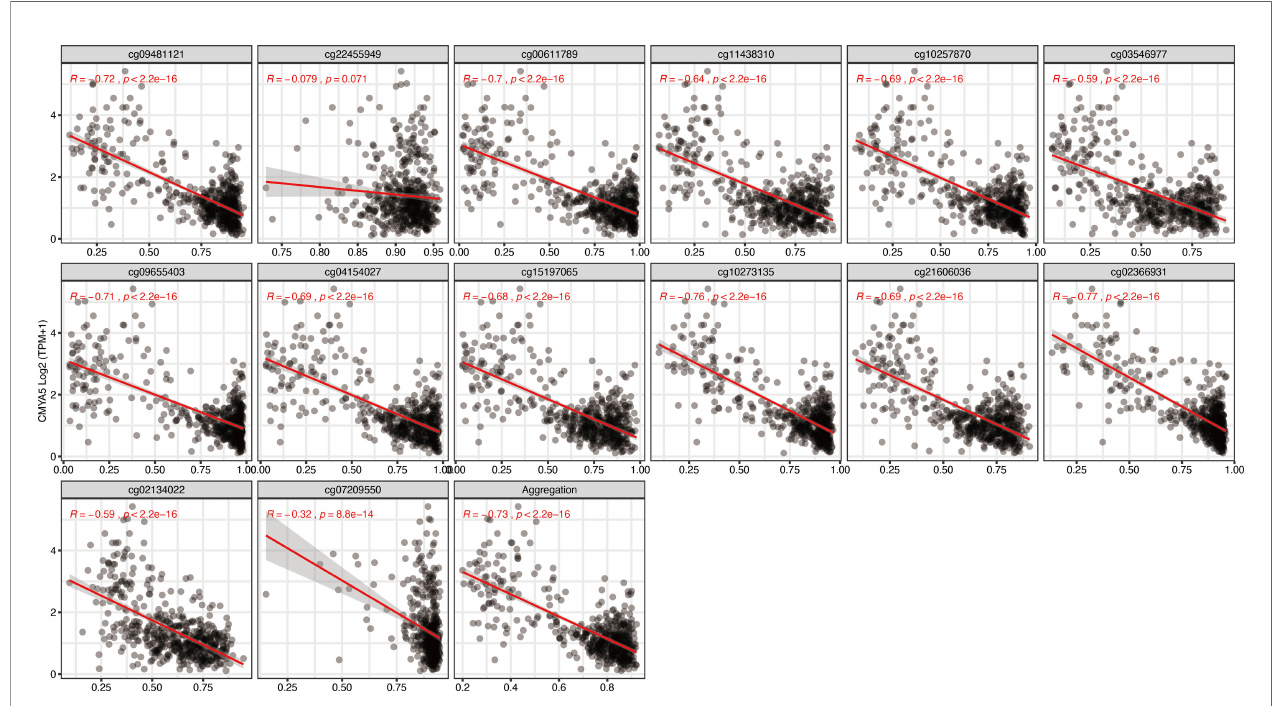
FIGURE 3 | Regression analysis involving each speci fi c CpG site and aggregated levels, and the expression of CMYA5 in the whole dataset from